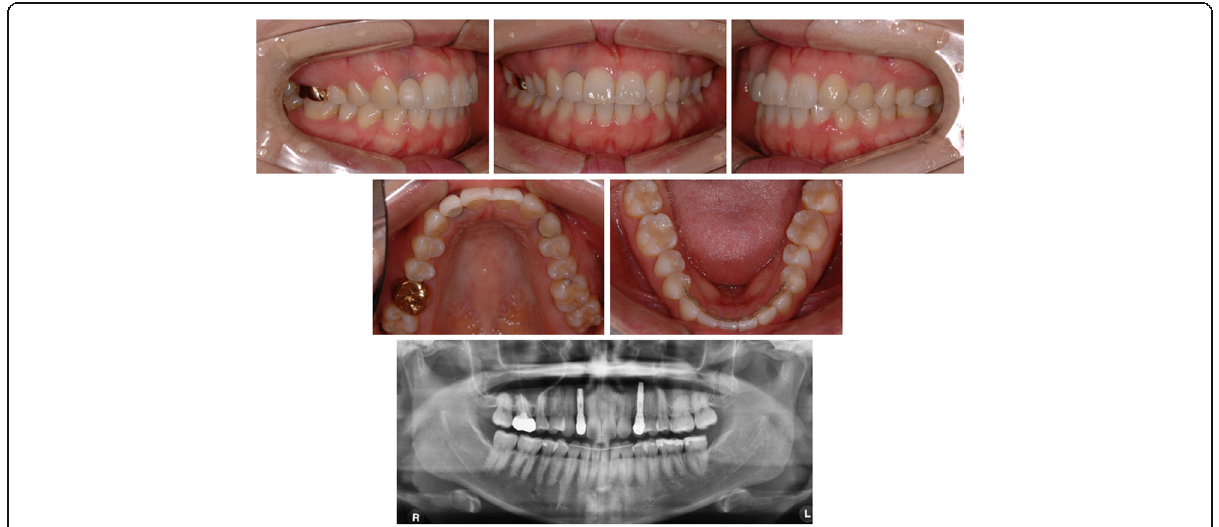
Fig. 6 Two-year post-treatment intraoral